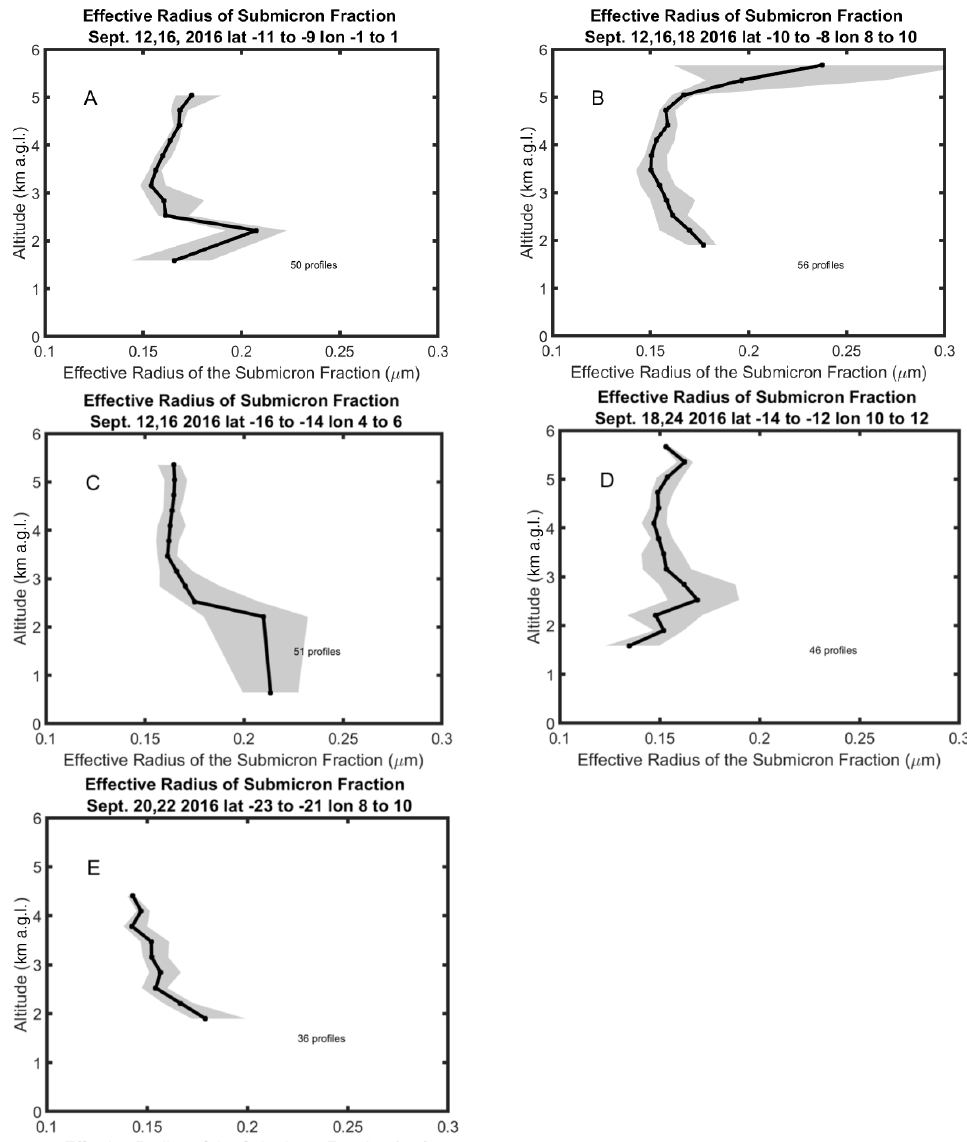
Figure 12. As in Fig. 11 but for the effective radius of the submicron